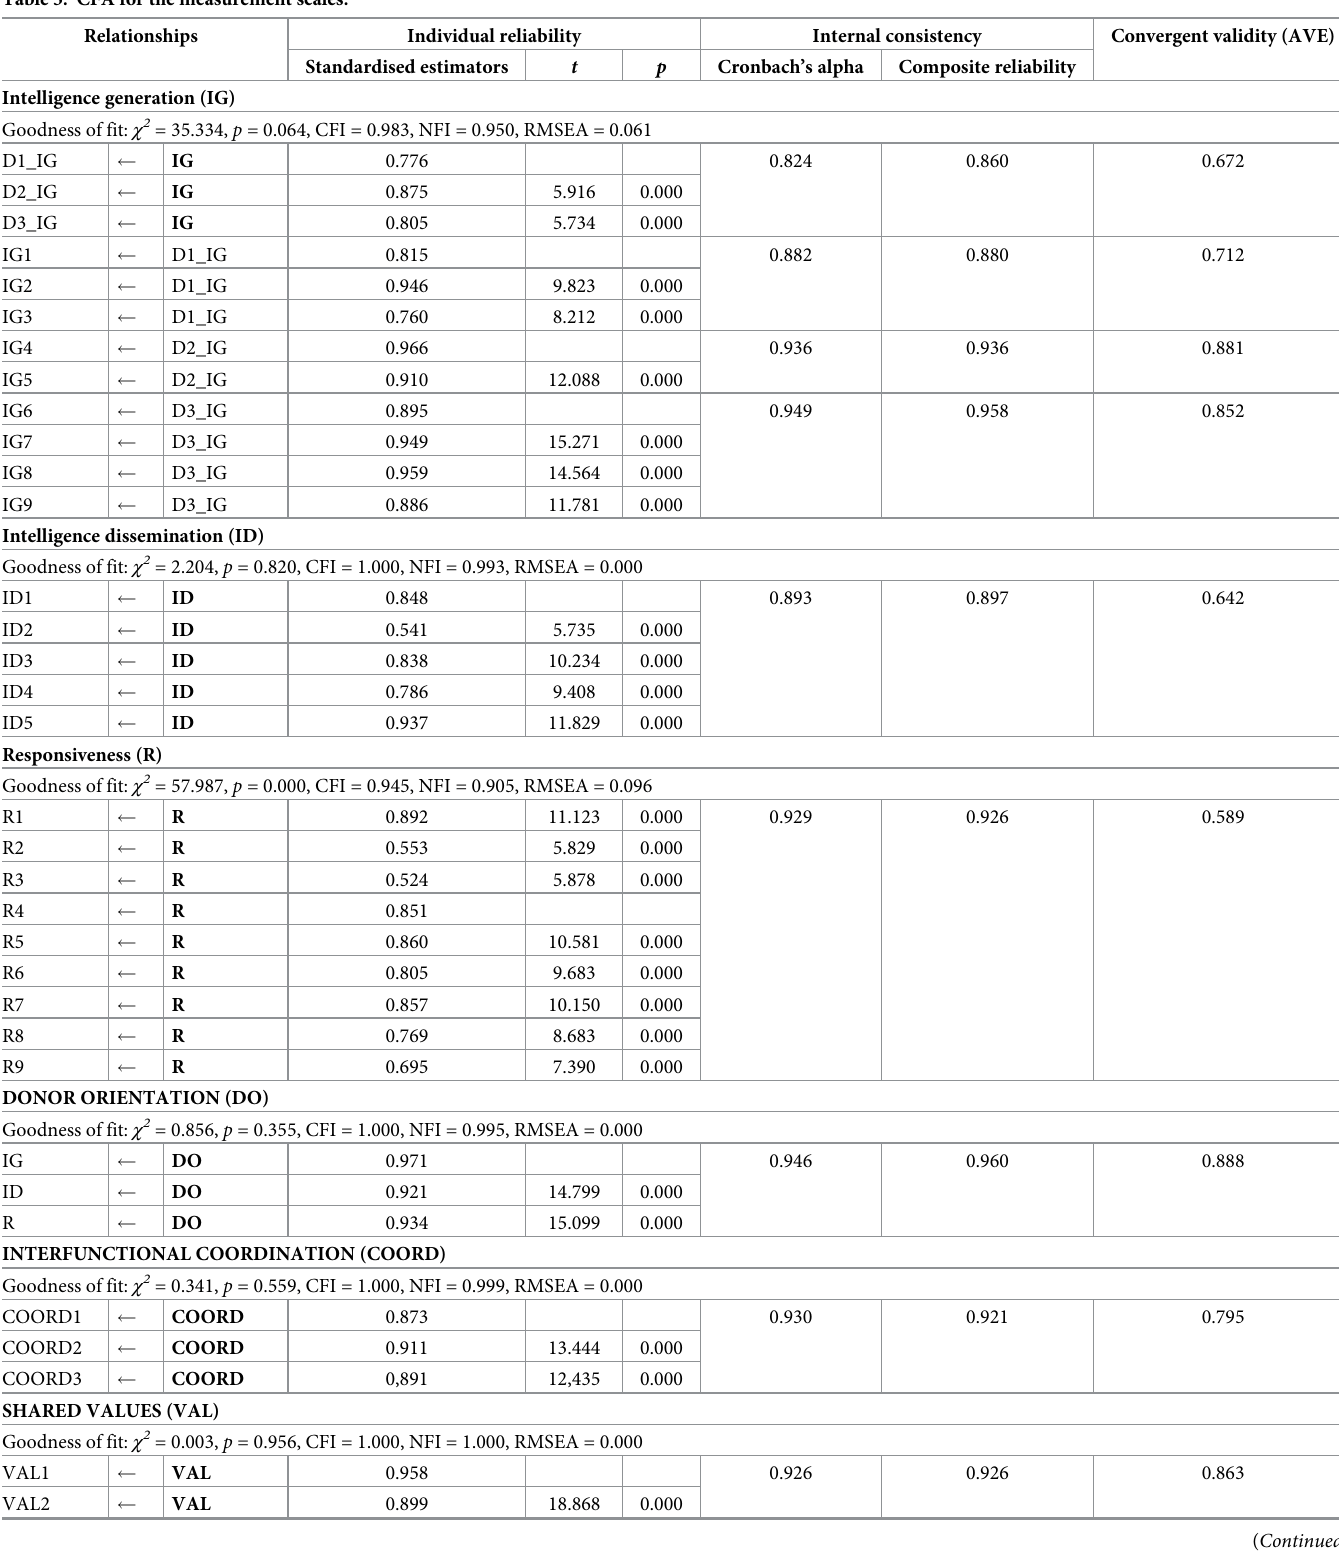
Table 3. CFA for the measurement scales. Relationships Individual reliability Internal consistency Convergent validity (AVE) Standardised estimators t p Cronbach’s alpha Composite